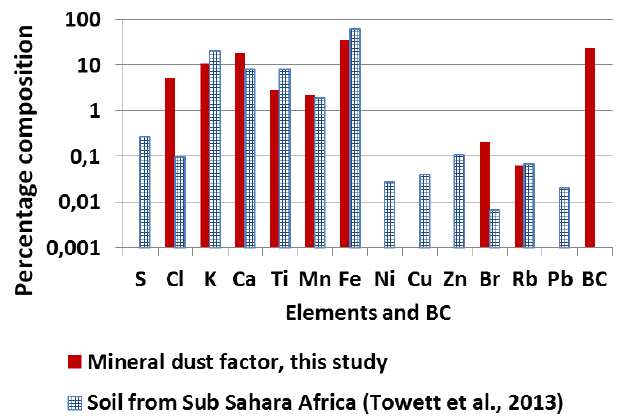
Figure 8. Mineral dust factor from the PMF analysis of PM 2 . 5 from this study compared with elements from soil samples from SSA countries (Towett et al., 2013).